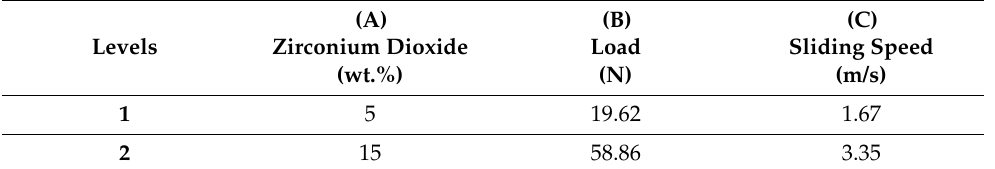
Table 4. Selected levels and factors (RSM).